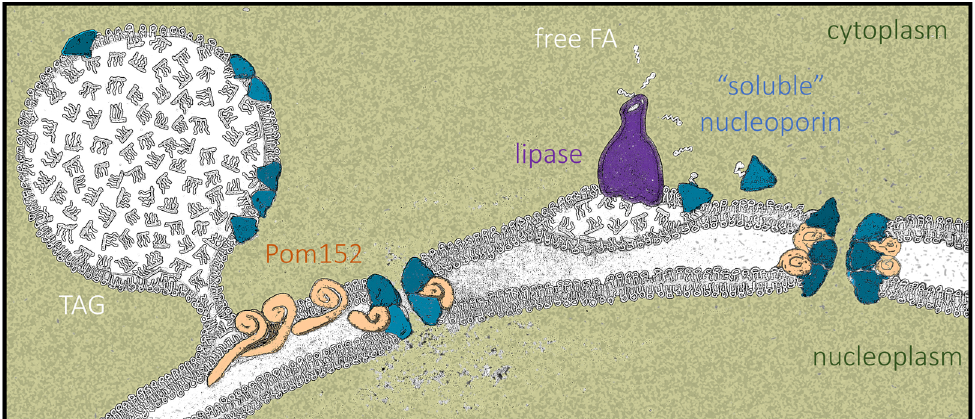
Figure 9. Model of how LD status impacts Nup configurations at the nuclear pores. left: TriAcylGlycerols (TAG)-filled LD create a landing platform for nucleoporins, which can attach by their own features (i.e., amphipathic helices), by interaction with other Nups, or by congregation in the perimeter of LD, e.g., in the case of Pom152. This may titrate nucleoporins away from the nuclear pore, defining a particular NPC stoichiometry that matches a specific transport and chromatin landscape profile. right: In the event of LD consumption, lipase activity releases individual fatty acids. We propose that these FAs may bind core Nups of the inner pore channel, such as Nic96 and Nup157, promoting a conformational change that permits their dissociation from LD and migration to the pore. Simultaneously, the decreased surface of the LD upon shrinkage will naturally promote the eviction of other Nups, as ruled by protein crowding [53], as well as the diffusion back to the ER of transmembrane proteins congregating in the vicinity of the LD [66]. The availability of these components at the NPC will specify a different profile of transport and alternative chromatin